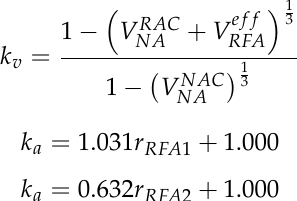
a and empirical value k v